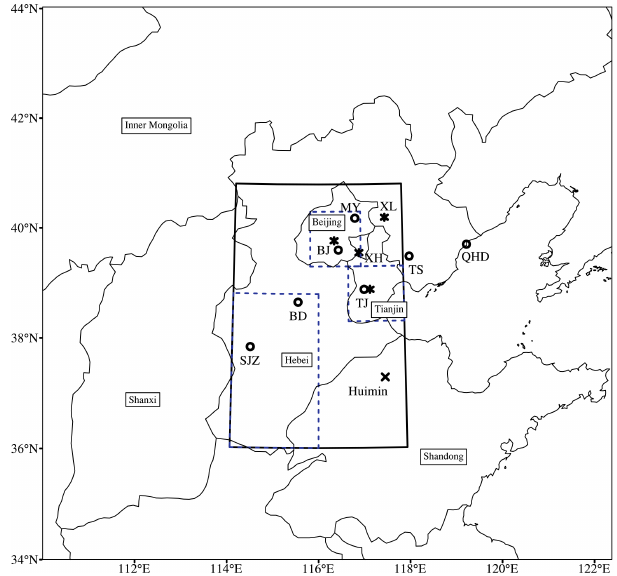
Figure 1. Study domain and regional divisions: Hebei, Beijing, Tianjin, Inner Mongolia, Shanxi, and Shandong. The observation sites (BJ, MY, BD, TS, TJ, QHD, and SJZ) from CNMC are de- noted by circles and those from the CARE-China network (BJ, TJ, XH, and XL) are denoted by stars, of which BJ and TJ from CNMC and the CARE-China network are very close. The observation sites (BJ, XL, and XH) from AERONET have the same locations as those from CARE-China. Huimin site from Che et al. (2014) is denoted by a cross. The black box denotes the region of Beijing, Tianjin, and Hebei (BTH region, 36.2–41 ◦ N, 114–118 ◦ E), and the three blue boxes with dashed lines denote Beijing, Tianjin, and south Hebei,